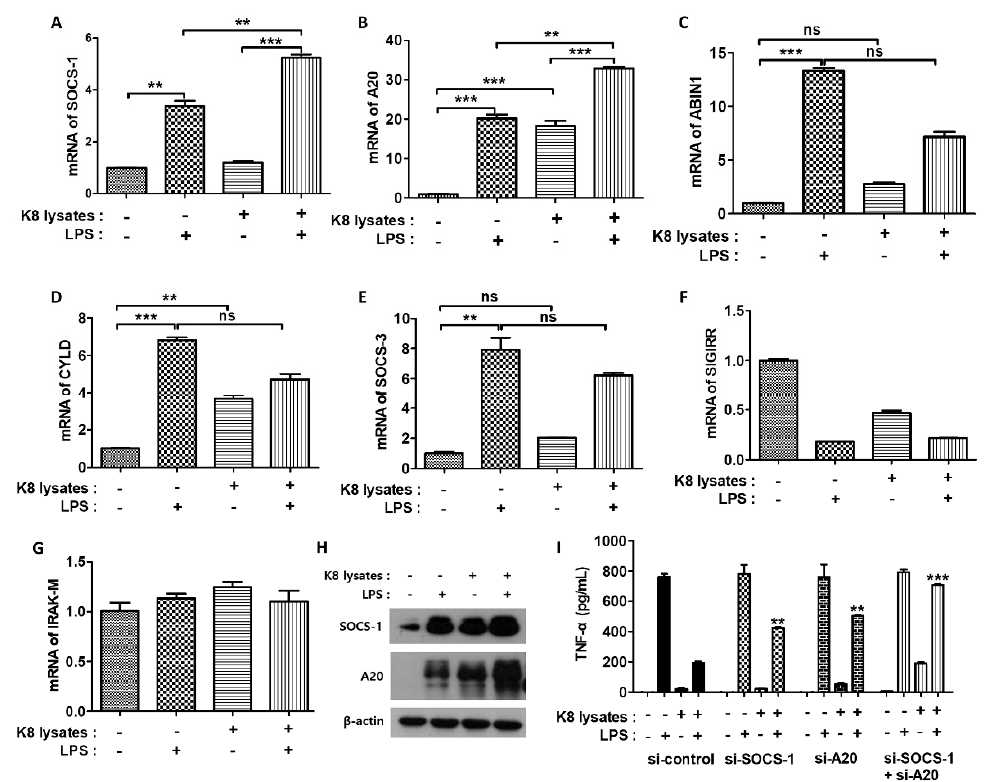
Figure 3. Suppressor of cytokine signaling (SOCS)-1 and tumor necrosis factor, alpha-induced protein 3 (A20) were involved in the down-regulation of signaling pathway initiated by L. plantarum K8 lysates and LPS. THP-1 cells were treated with 1 × 10 8 CFU/mL L. plantarum K8 lysates for 18 h and/or 500 ng/mL of LPS for 4 h. mRNA levels of SOCS-1 ( A ), A20 ( B ), A20-binding inhibitor of NF- κ B (ABIN1) ( C ), CYLD lysine 63 deubiquitinase (CYLD) ( D ), SOCS-3 ( E ), single Ig IL-1-related receptor (SIGIRR) ( F ), and interleukin-1 receptor-associated kinase (IRAK)-M ( G ) were measured by real-time PCR. (C) Protein levels of SOCS-1, A20 and β -actin were measured by western blot analysis. ( H ) THP-1 cells were transiently transfected with 25 nM of control (SI03650318), SOCS-1 (GS8651), or A20 (SG7128) siRNA purchased from Qiagen. After 36 h transfection, cells were stimulated with L. plantarum K8 lysates and/or LPS. The TNF- α level in the culture supernatants was determined using ELISA. Statistical analysis was conducted with one-way ANOVA followed by Tukey’s HSD post hoc test ( A – G ) and two-way ANOVA ( I ). ** p < 0.01; *** p < 0.001; ns, not